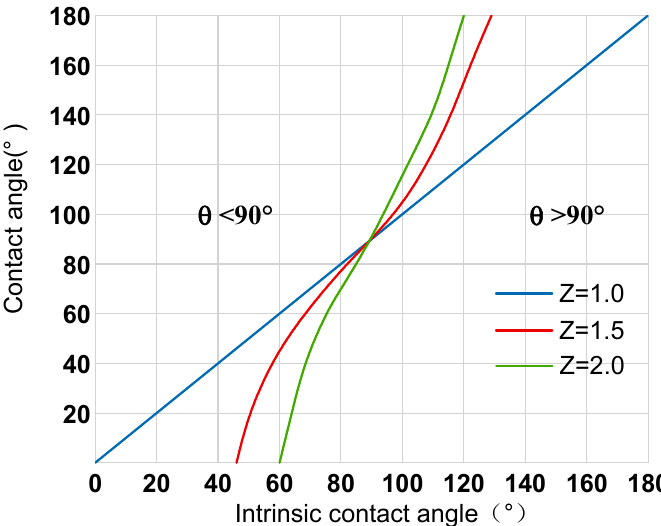
Figure 4. Effect of roughness on contact angle.